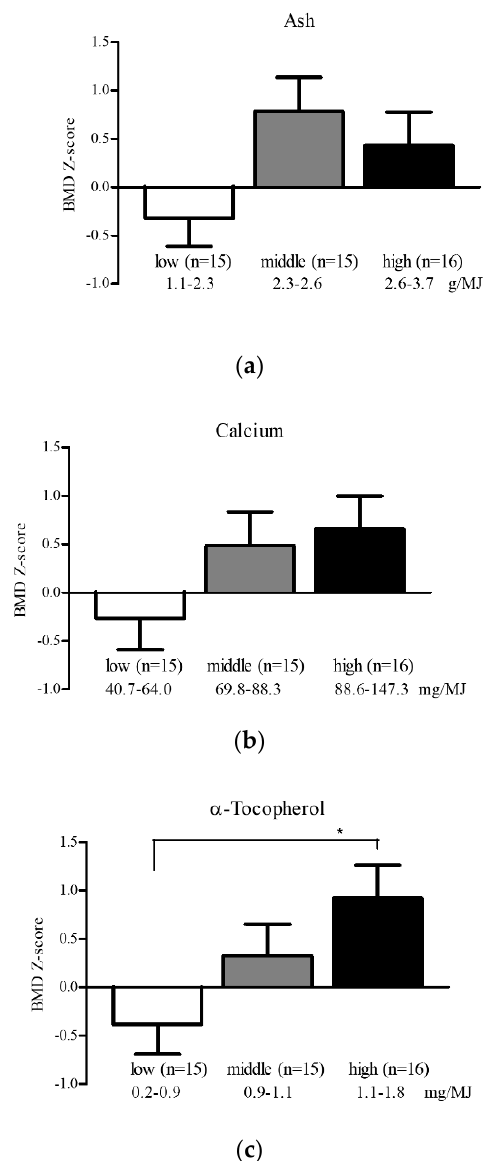
Figure 2. Differences in BMD Z-score by tertiles of ( a ) ash; ( b ) calcium; and ( c ) α-tocopherol intake in premenopausal women. Data are presented as mean and standard error. * p < 0.05 versus low consumption group, one-way ANOVA. BMD, bone mineral density; ANOVA, analysis of variance. Significant difference in BMD Z-score was observed between the α-tocopherol tertiles in premenopausal women.